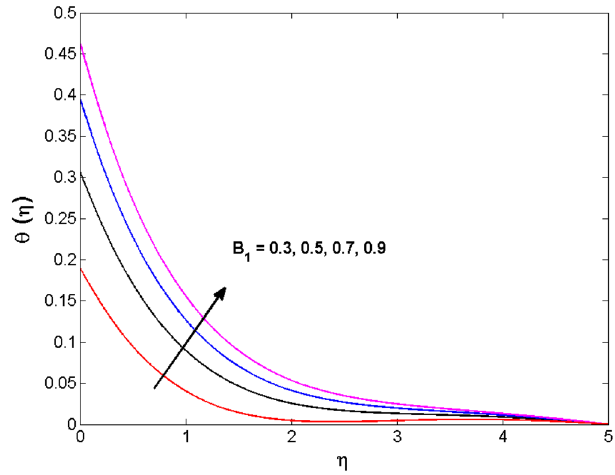
Figure 10. Variations of B 1 to θ (η) .